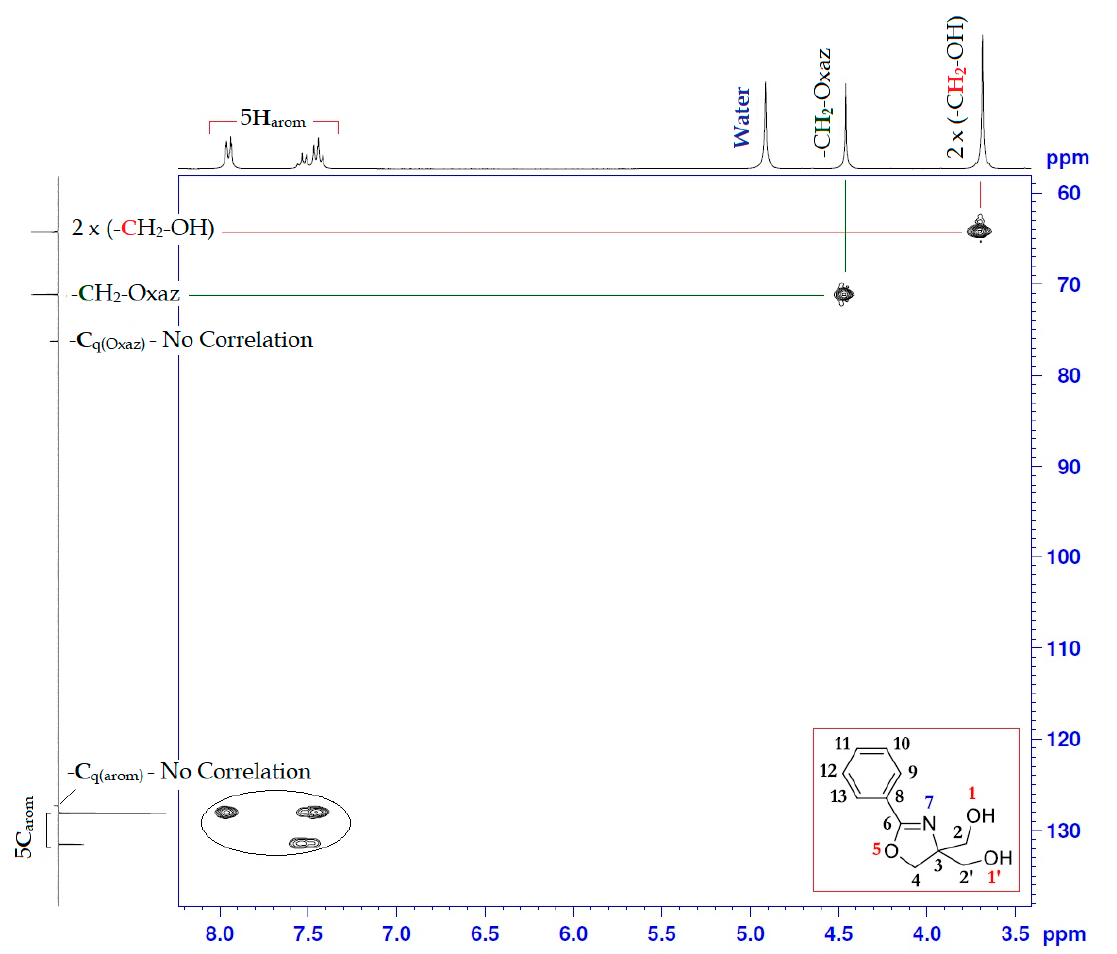
Figure 1. 1 H- 13 C Heteronuclear 2D spectrum (in CD 3 OD) of compound 2 .